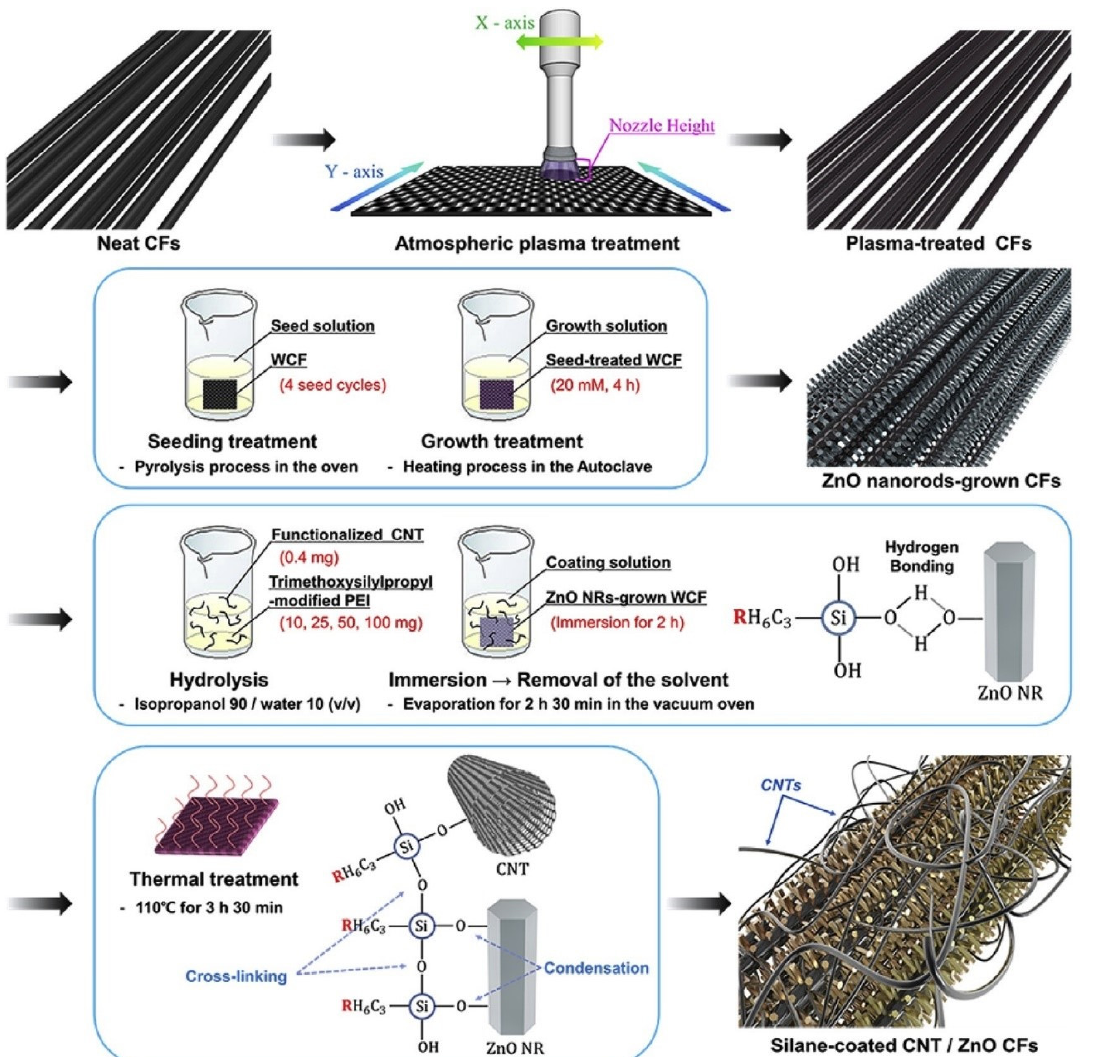
Figure 9. Processing schematics of ZnO NRs growth, CNTs-modified silane coating on CF surface (reprinted with permission) [54].